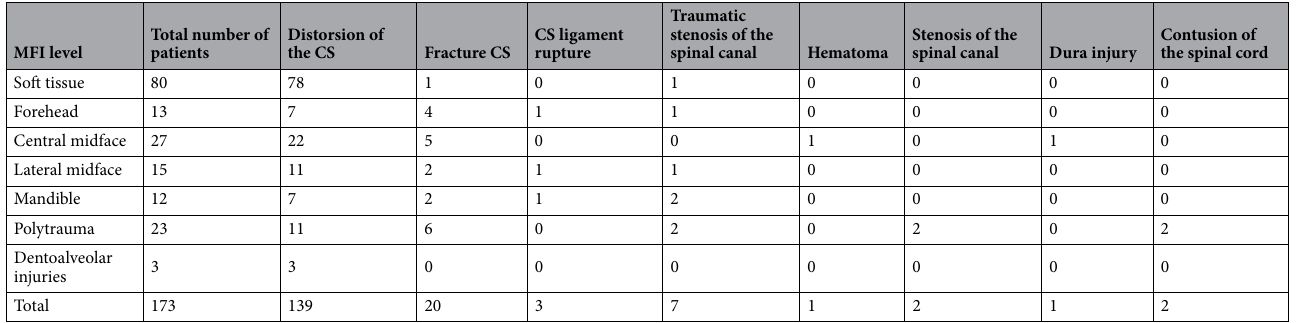
Table 3. The relation between the level of MFI and the detailed CSI diagnosis. CS cervical spine. The numbers represent absolute values.